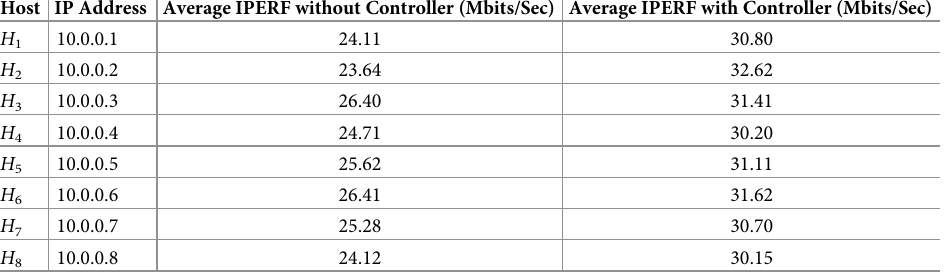
Table 2. Average Internet Performance (IPERF) of the